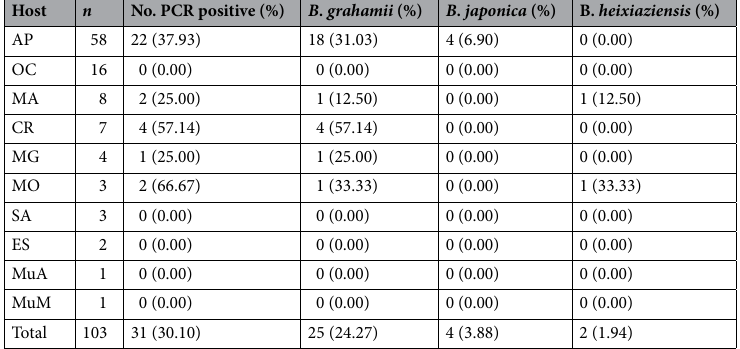
Table 1. Distribution of Bartonella infection in different small mammals. AP Apodemus peninsulae , OC Ochotona curzoniae , MA Microtus arvalis , CR Cricetidae , MG Microtus gregalis , MO Microtus oeconomus , SA Sorex araneus Linnaeus , ES Eozapus setchuanus , MuA Mustela altaica , MuM Mus musculus.